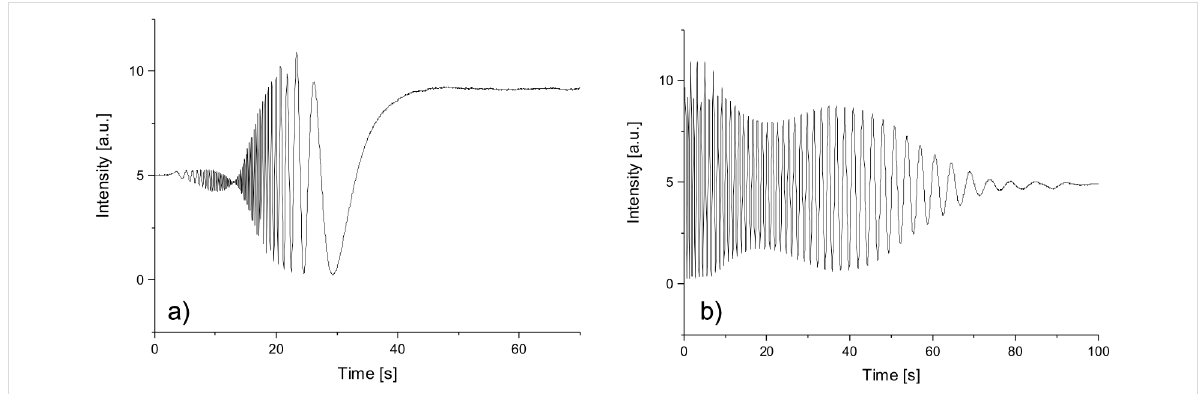
Figure 5: Experimental results plots for 0.1050 T magnetic field applied to the 5CB cell a) the field was applied, b) the field was disconnected.